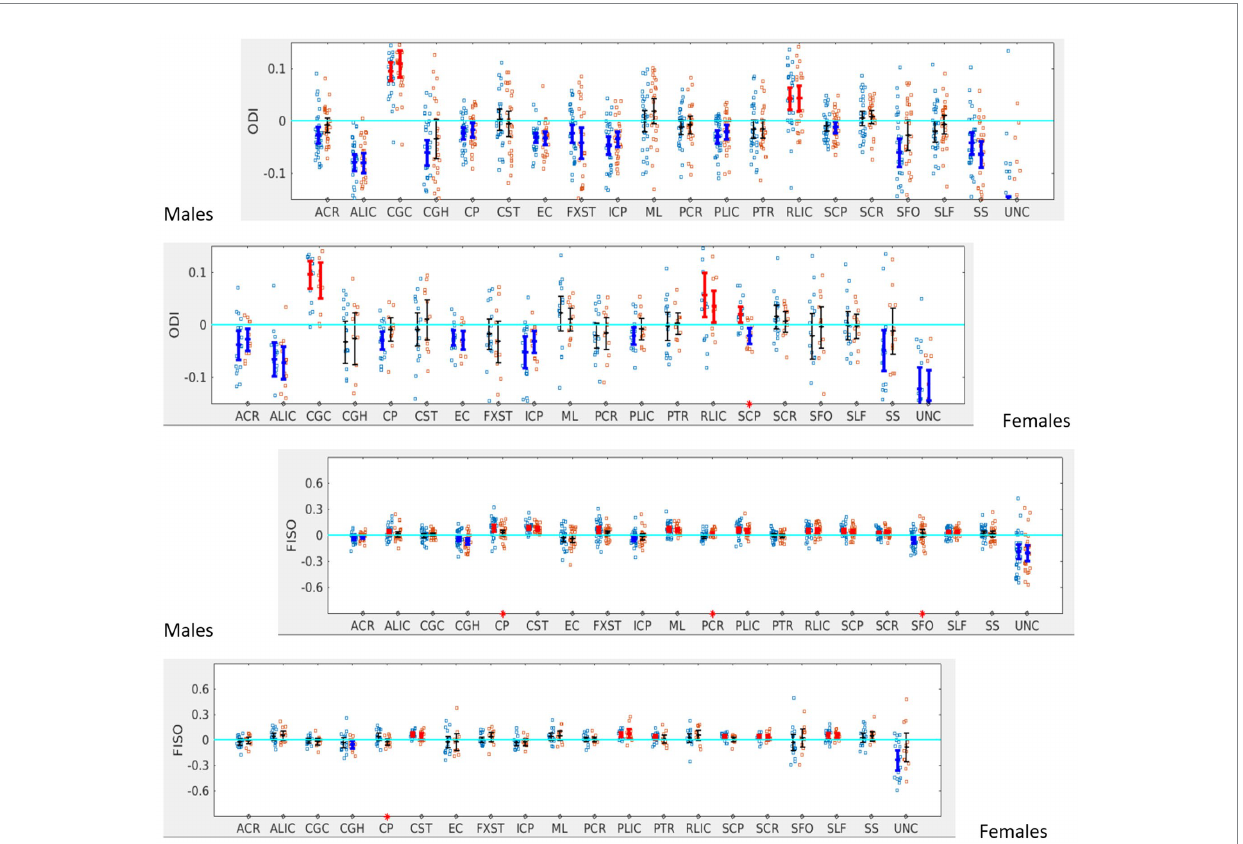
FIGURE 6 LI plotted for boys ( n = 58) and girls ( n = 29) separately for the 20 bilateral tracts for ODI and FISO comparing SOR (blue dots) to non-SOR (red dots) means with 95% CI are resented in the figure for SOR and Non SOR, 95% CI bars in red represents significant right lateralization (positive LI) of the tract while blue bar represents significant left lateralizatin (negative LI) of the tract. There were no significant differences between SOR and non-SOR NDI and hence these are not analyzed saperatly for males and females. Red asterisks on the X axis represent tracts for which difference between SOR vs. non SOR was significant at p <